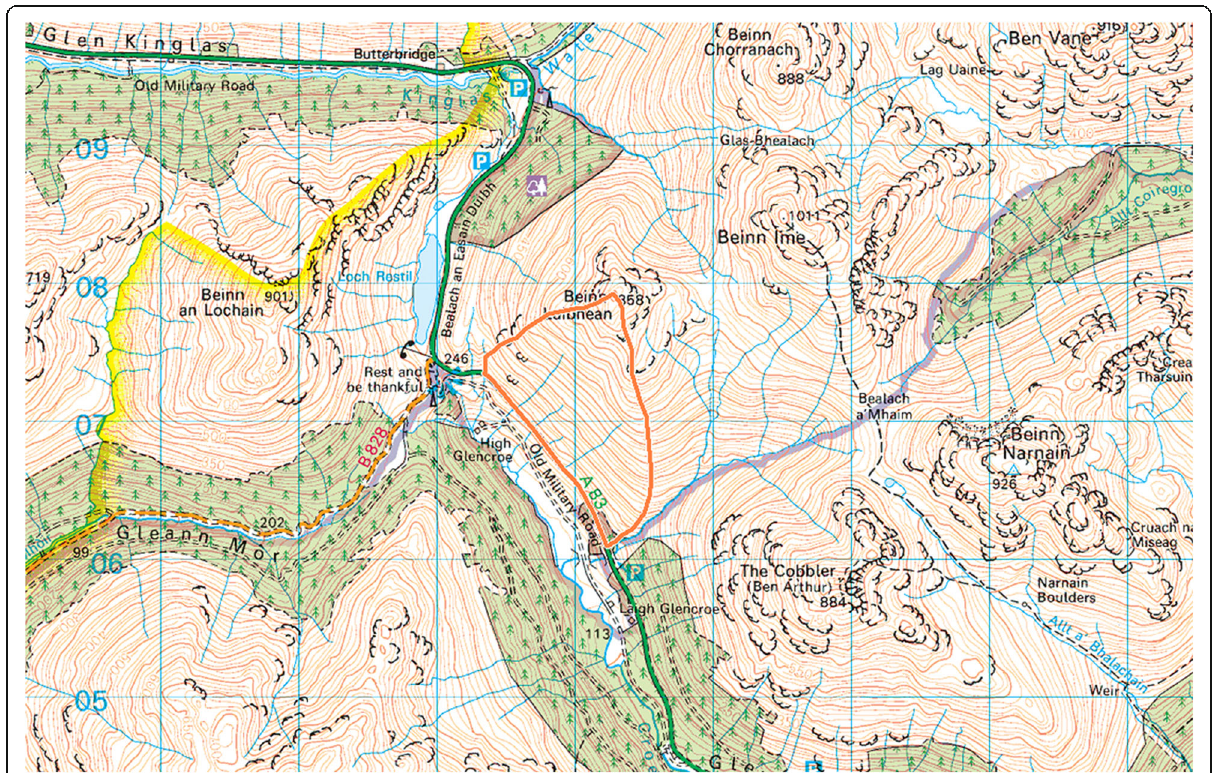
Fig. 3 Location plan of the A83 Rest and be Thankful study area outlined in red (Ordnance Survey 1:50,000, not to scale). Reproduced by permission of Ordnance Survey, on behalf of HMSO,© Crown copyright and database rights, 2020. All rights reserved. Ordnance Survey